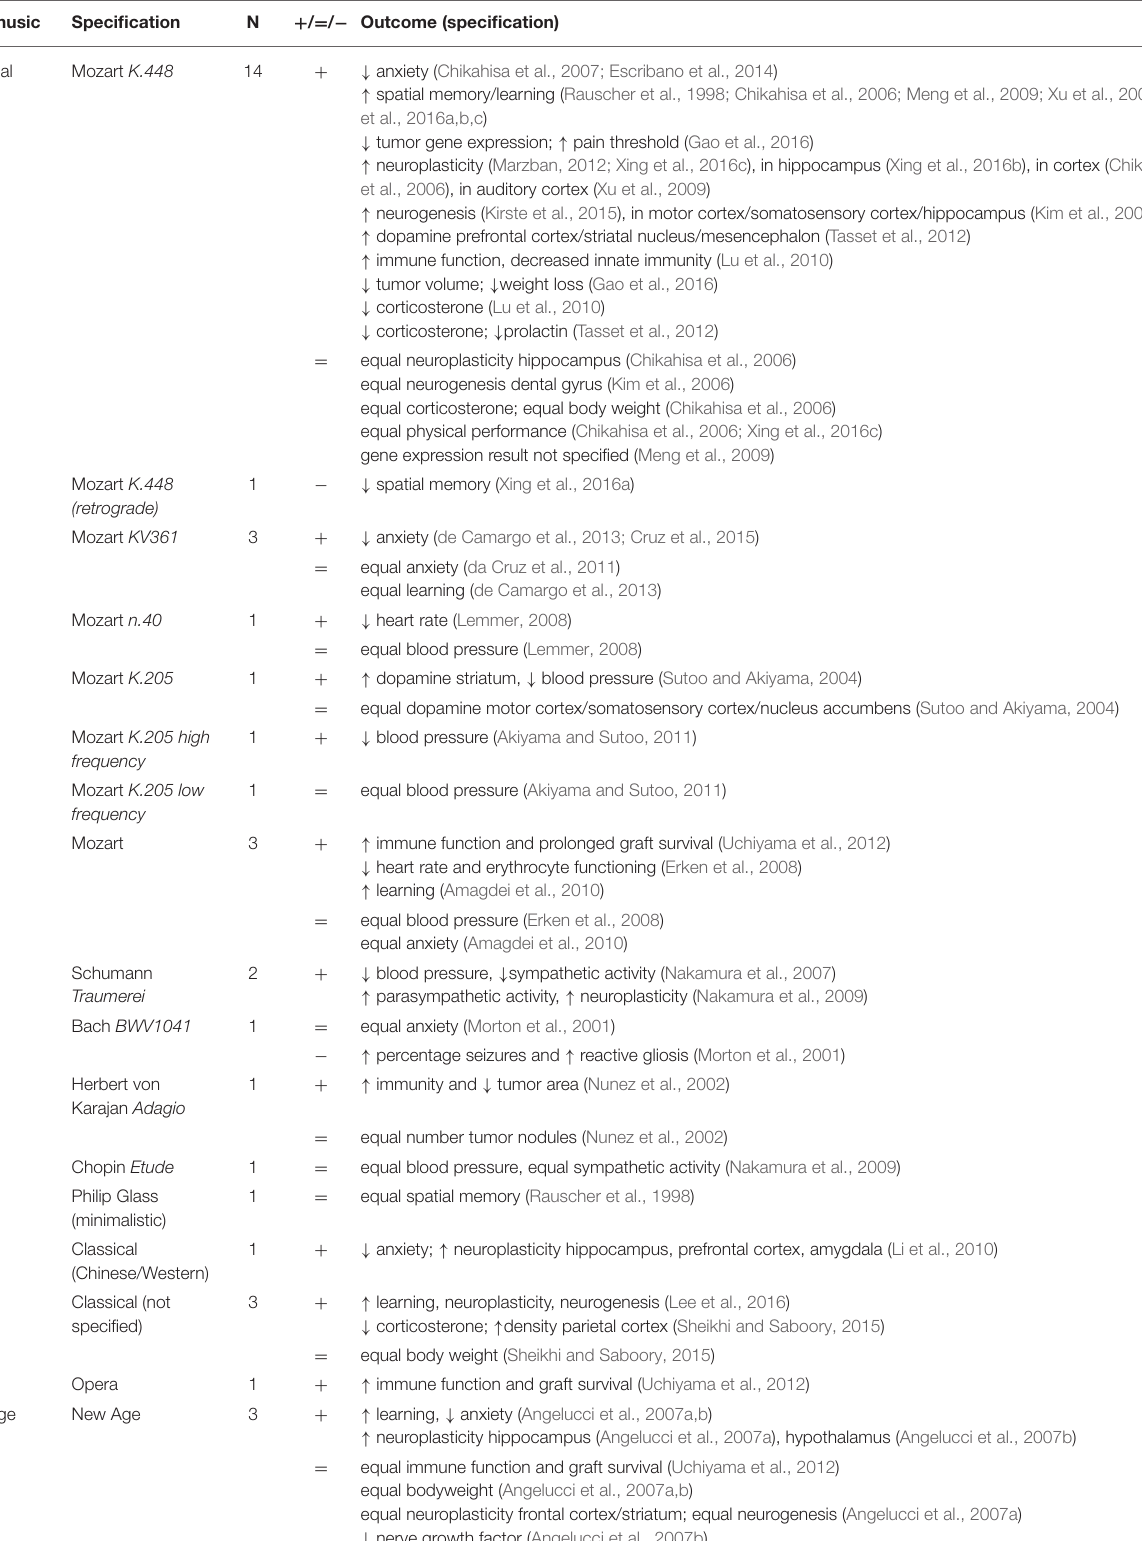
TABLE 6 | Music genres and their effect on